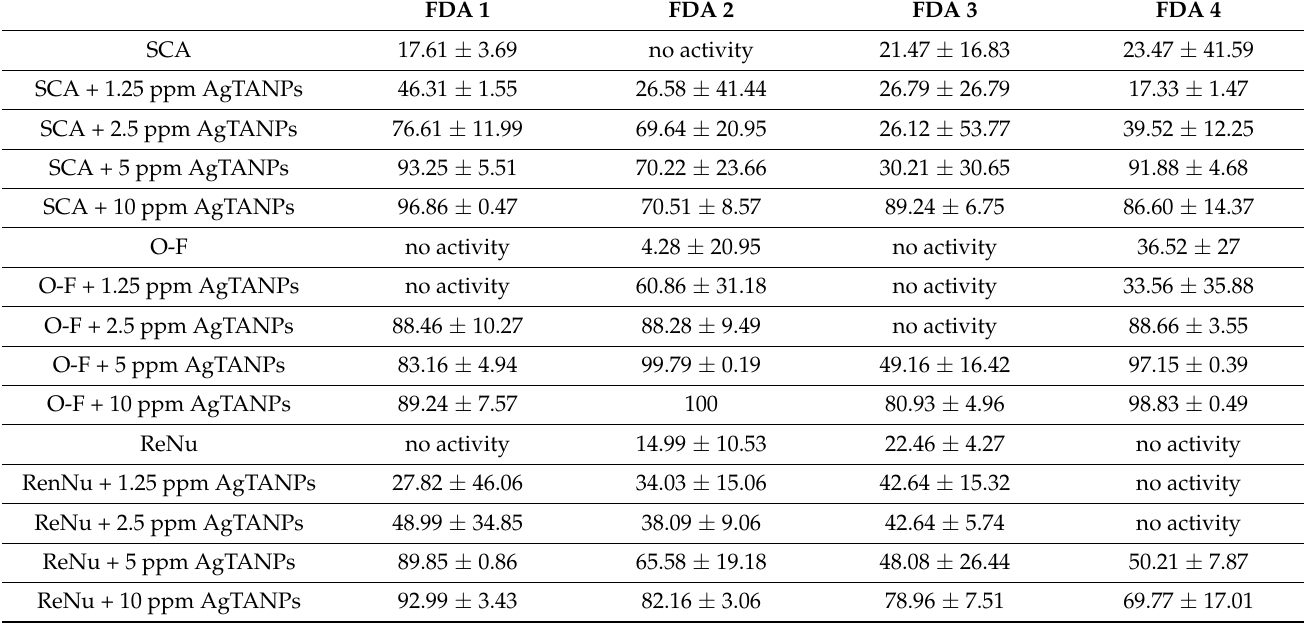
Table 3. Percentage (%) of amoebae adhesion reduction (AR) ± standard deviation (SD) after incubation with tested agents depending on the FDA type of contact lenses